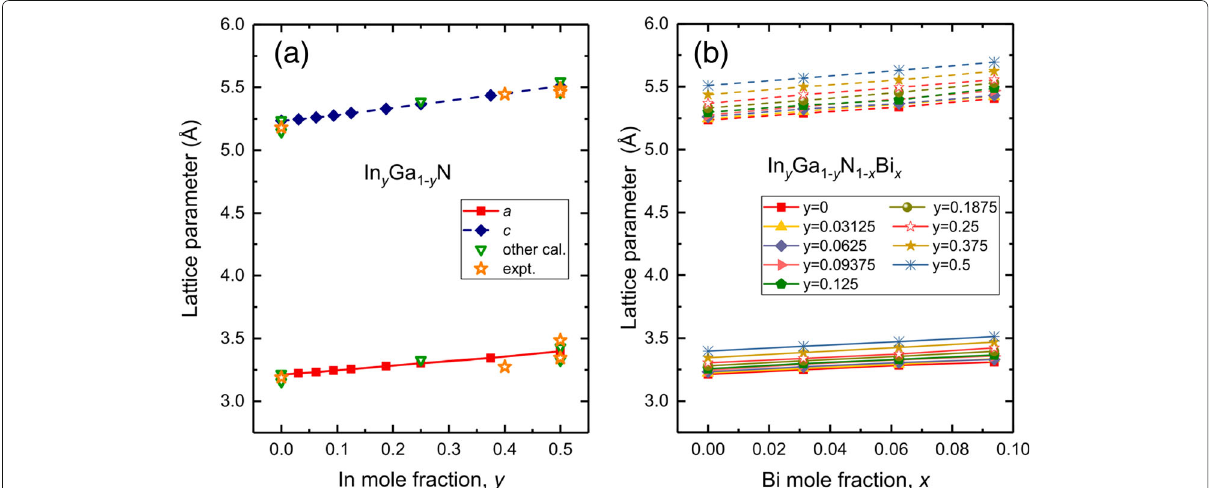
Fig. 1 The lattice parameters for a ternary alloys In y Ga 1 − y N , with 0 ≤ y ≤ 0.5 and b quaternary alloys In y Ga 1 − y N 1 − x Bi x , with 0 ≤ x ≤ 0.09375, 0 ≤ y ≤ 0.5. For comparison, we add some other calculations and experimental data from Ref. [39–44] in Fig. 1a. The solid line represents a and dashed line is c